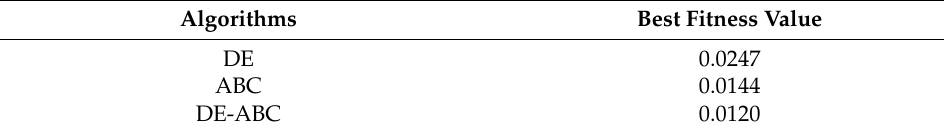
Table 2. The parameters of the model.